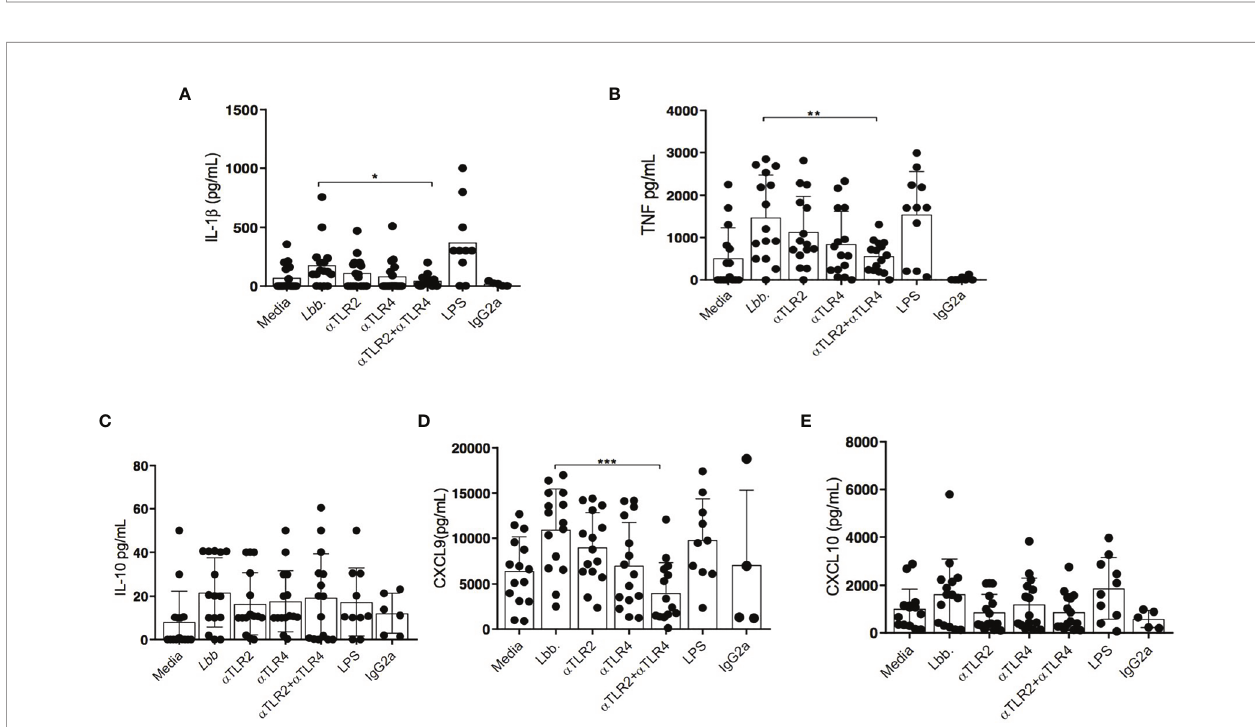
FIGURE 4 | Evaluation of cytokine production by CL monocytes after TLR2 and TLR4 neutralization. Monocytes from CL patients (n = 15) were treated or not with anti-TLR2 and anti-TLR4 antibodies, then infected with L. braziliensis (5:1) for 48 hours. IL-1 b (A) TNF (B) , IL-10 (C) , CXCL9 (D) and CXCL10 (E) were quanti fi ed by ELISA. Data are representative of median cytokine production. Wilcoxon signed-rank test; *p<0.05, ** p<0.01,